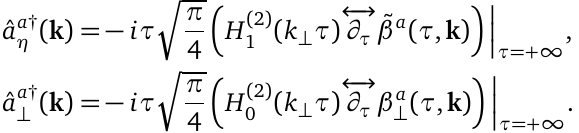
and g 5 ρ 3 , only two representative P P